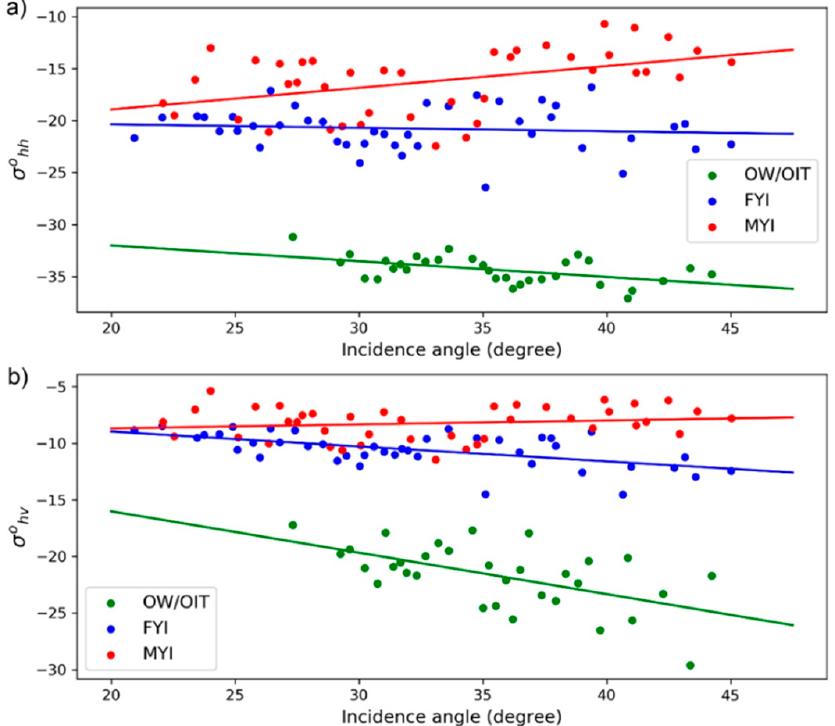
Figure 3. Backscatter coefficient as a function of incidence angle for various ice types at co-polarized σ o ( a ) and cross-polarized channels σ o ( b ). OW / OIT (32 points), FYI (42 points), MYI (41 points).